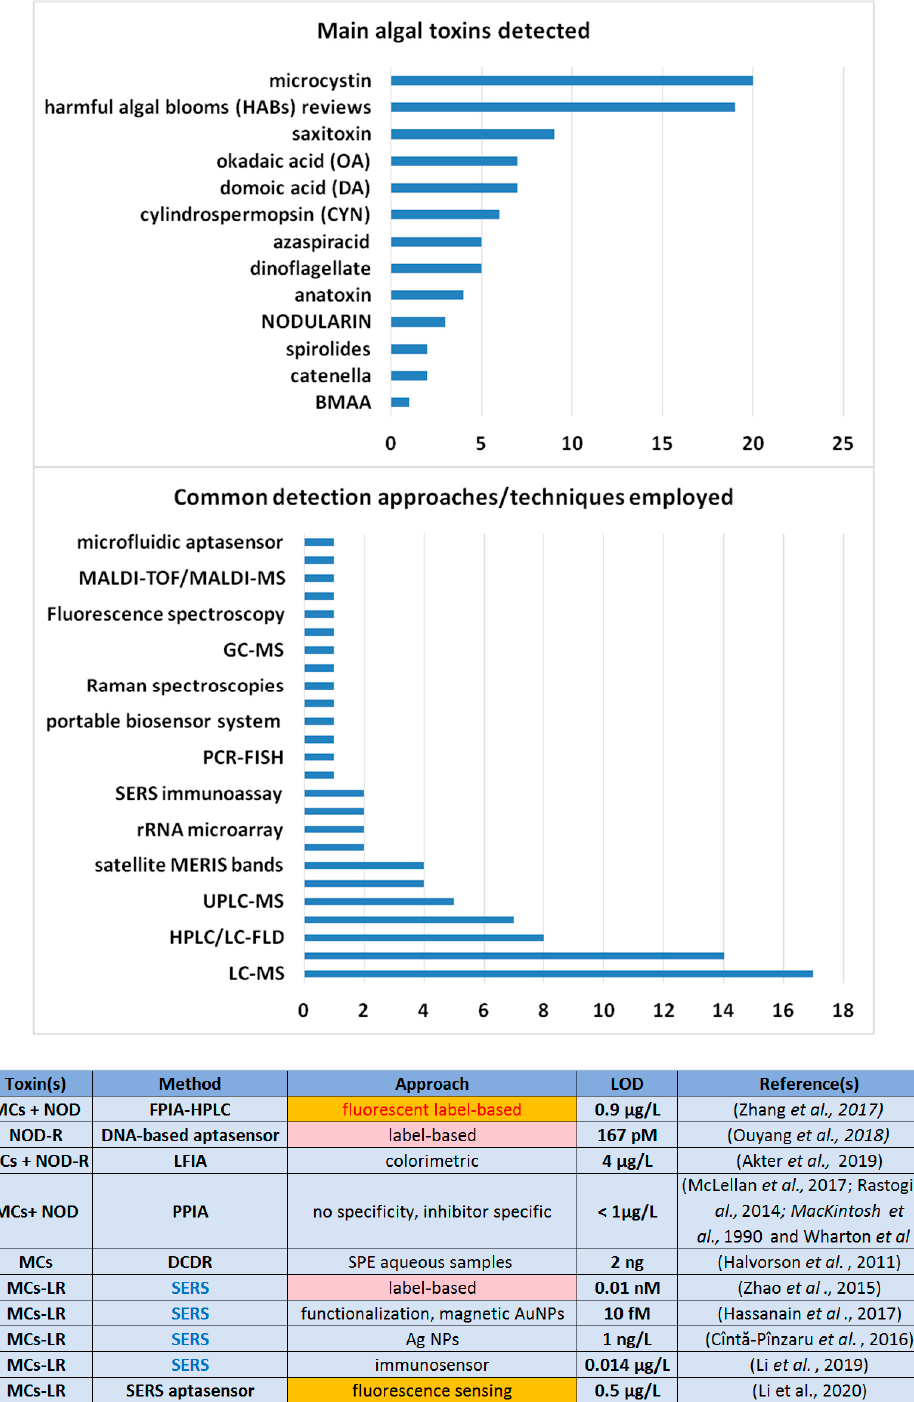
Figure 1. Main algal toxins correlated with blooming, and the most relevant techniques used for their detection as reported between 2017 and 2022 (source—Web of Science Collection). A table summarizing the lowest LODs obtained by using label-based approaches or elaborated platforms designed for trace-level detection [30–32,36,48–50,54,57,63–65,67].